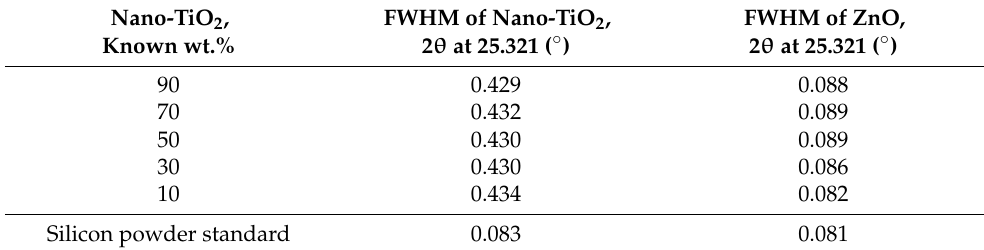
Figure 3. The XRD patterns of five artificial mixtures with varying weight fraction ratios ( a ). The strongest peaks of nano-TiO 2 and ZnO were fitted using PVF to obtain peak shape parameters ( b ). Then, the IB curve obtained by fitting the FWHM of the five strongest peaks of the silicon powder standard was compared with the strongest peak FWHM of nano-TiO 2 and ZnO (two-theta at 25.321°, 36.251°, respectively) ( c ). Table 2. Peak shape parameters and quantitative results in five artificial